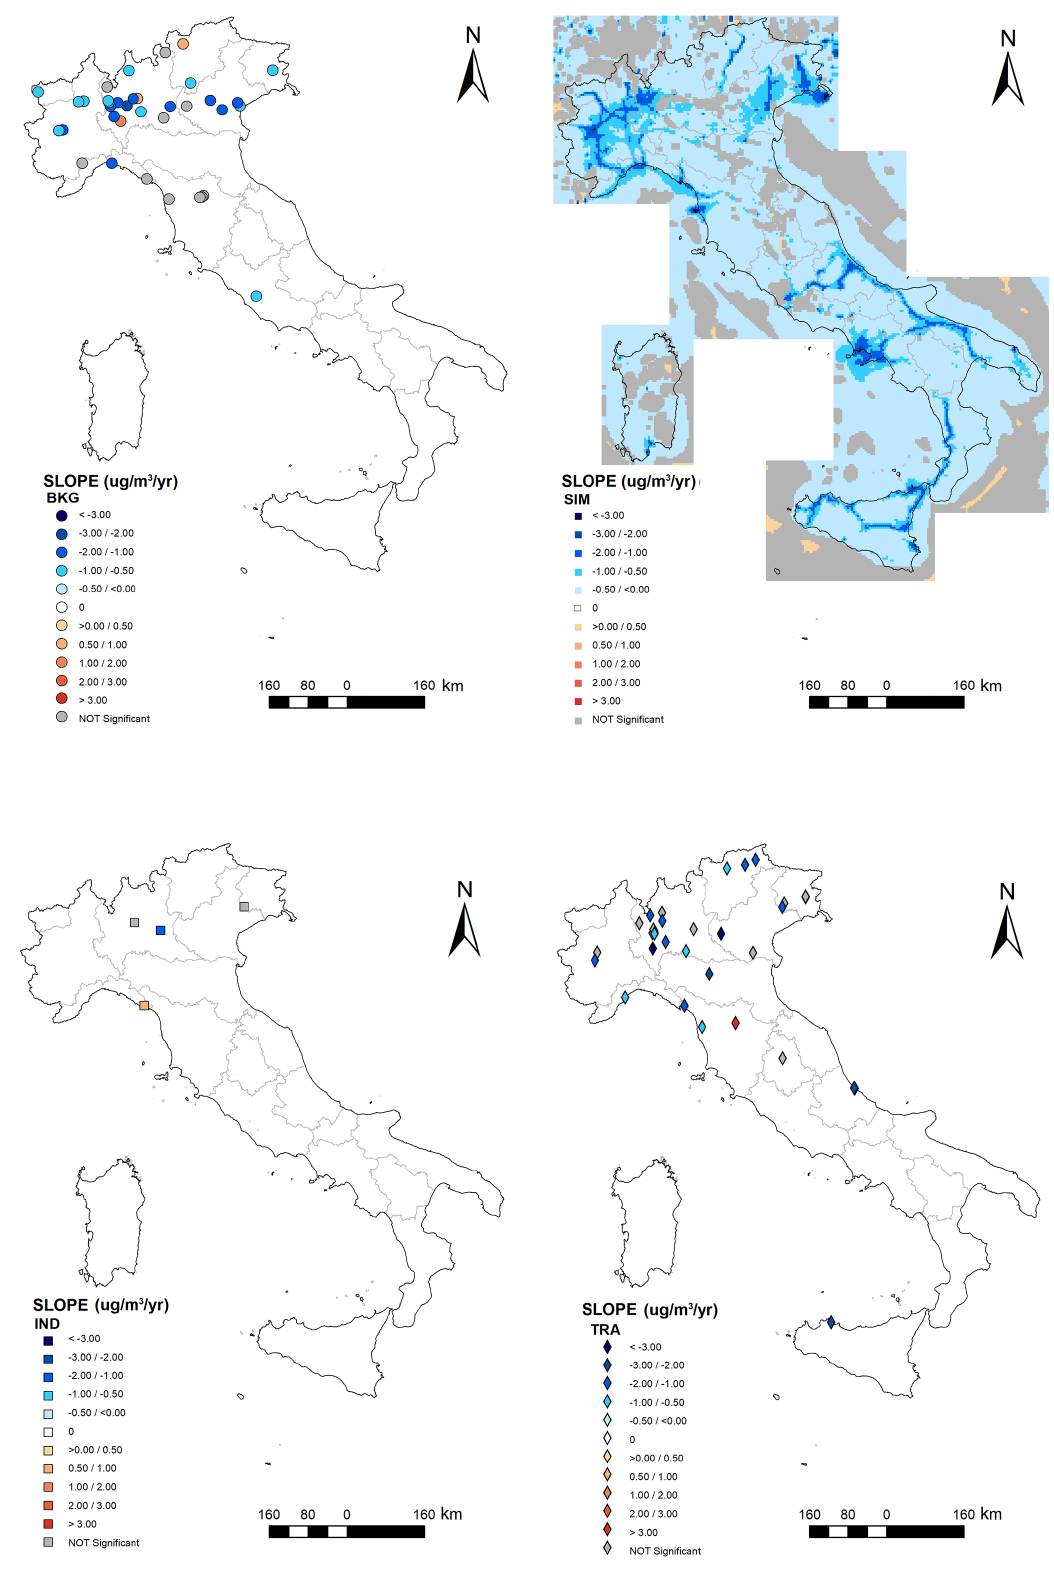
Figure 6. Slopes of NO 2 (µgm − 3 yr − 1 ) observed at background (BKG – upper left panel), industrial (IND – lower left panel), and traffic (TRA – lower right panel) stations and simulated (upper right panel) slopes at each grid point. The grey symbols refer to non-significant trends for both the observations and the simulated